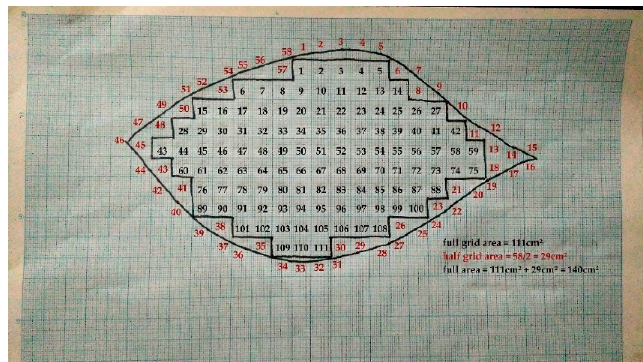
Figure 7. Printed leaf on a millimeter grid paper.